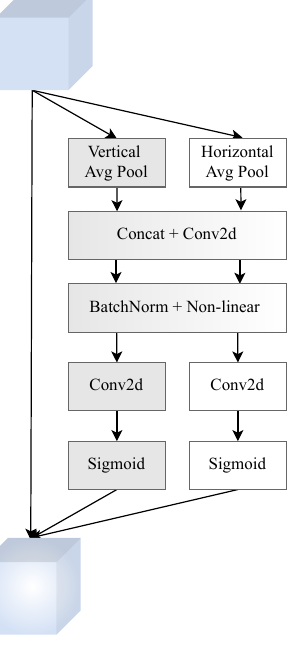
Figure 1. Structure of the